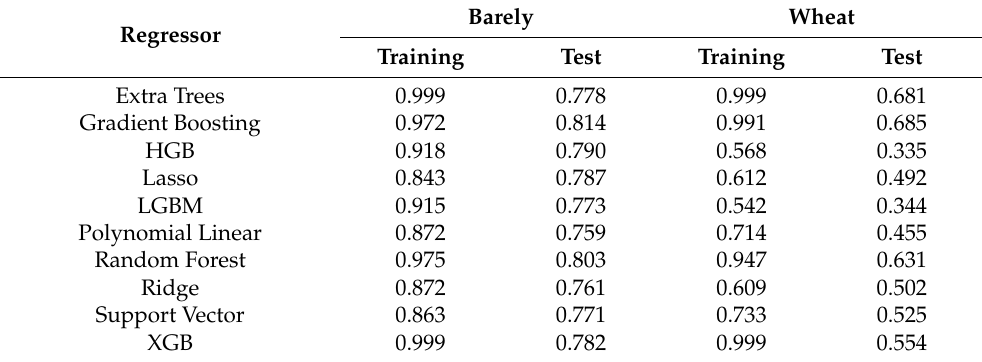
Table 2. Training and test scores for the leaf area index estimation analyses of barley and wheat in relation to remote sensing data using ten machine learning regression models. Barely Wheat Regressor